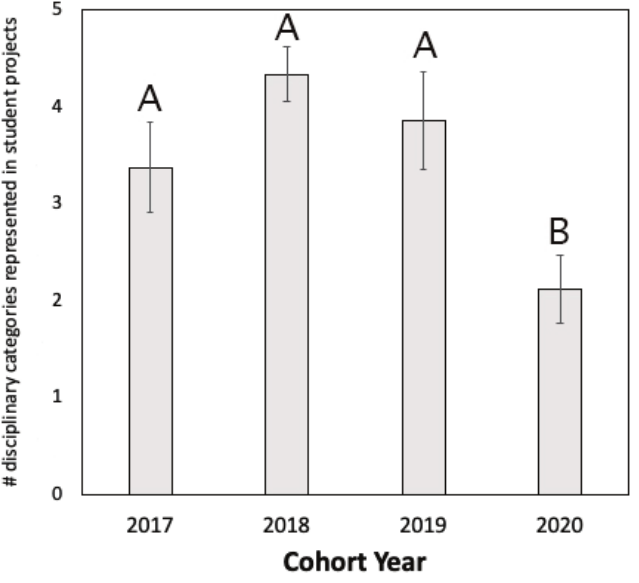
Figure 3: Average number of the nine components that students incorporated into their final project, by year. One-way ANOVA shows that students in the 2020 cohort (who did not go abroad) integrated fewer components into their